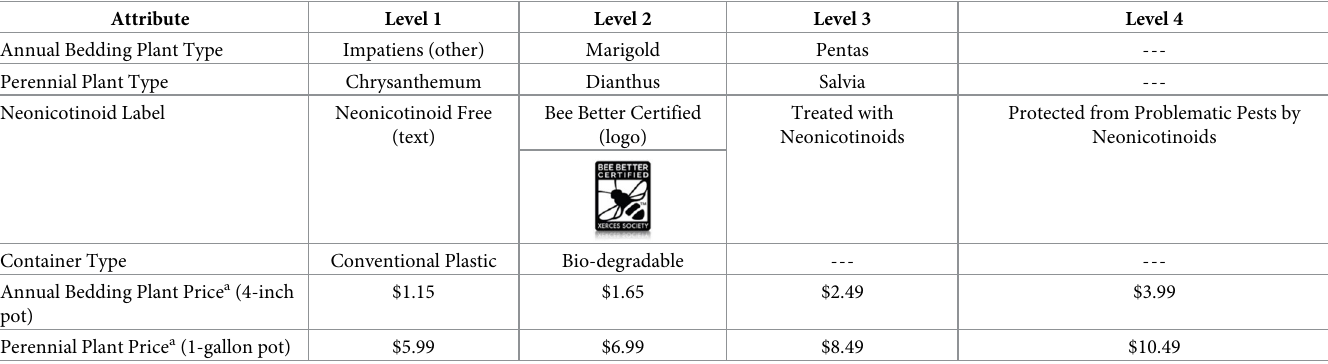
Table 1. Attributes and attribute levels used in the discrete choice experiment and experimental